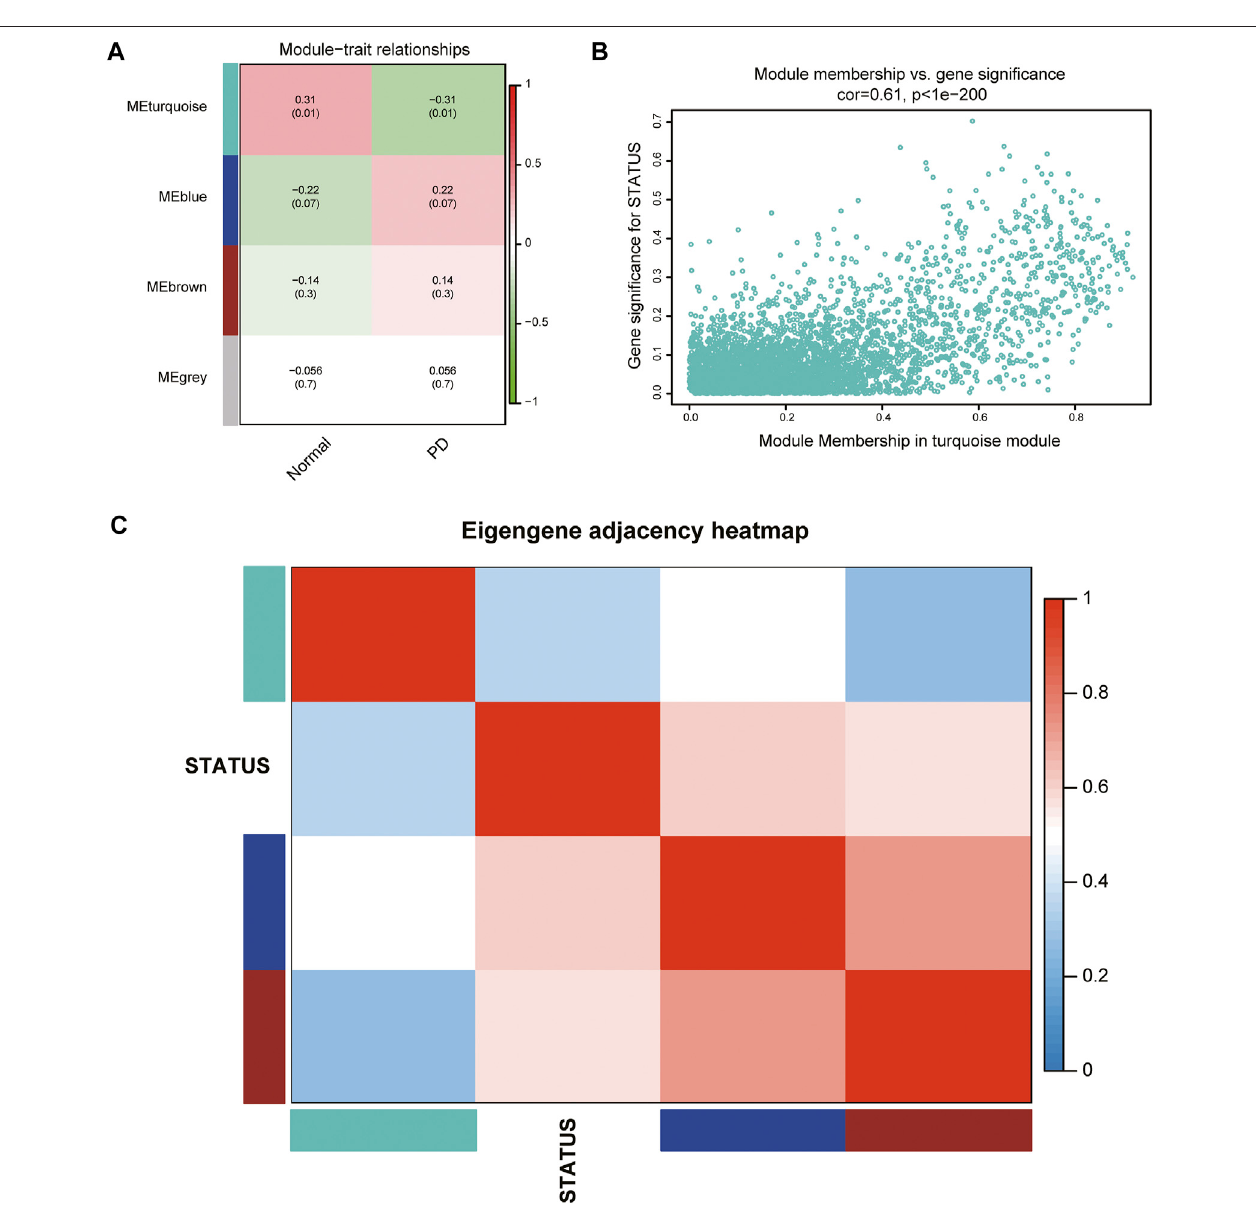
FIGURE 3 | Identi fi cation of key modules associated with PD. (A) Heatmap of correlations between MEs and phenotype of clinical traits (type of disease). Red represented positive correlation and green represented negative correlation, and the corresponding p value was indicated in brackets. (B) GS and MM in the turquoise module. (C) Heatmap of the eigengene network representing the relationships among the modules and the clinical trait status.